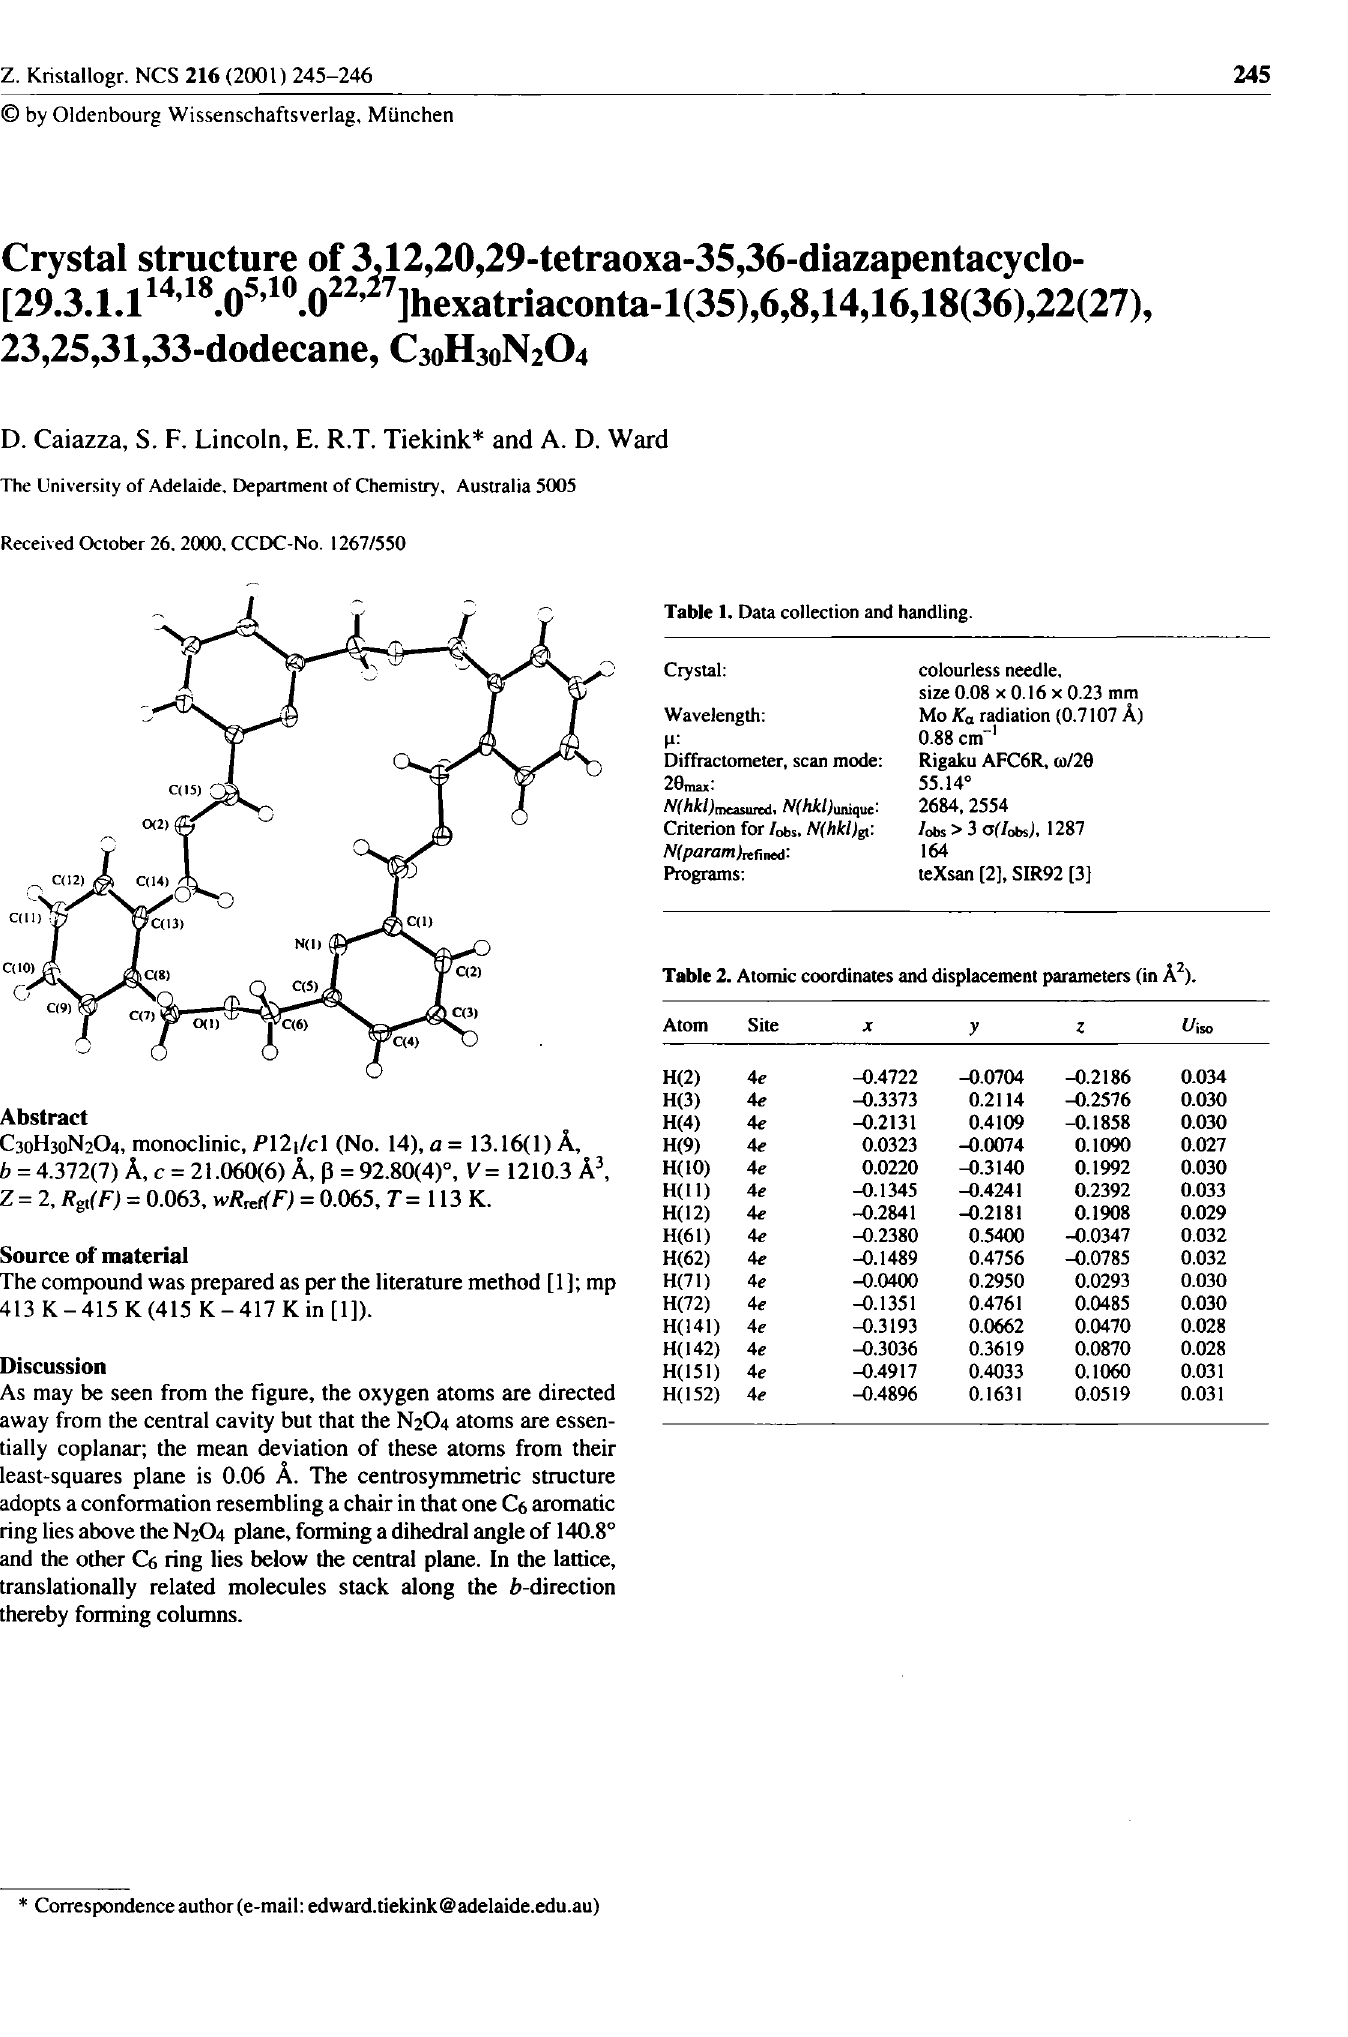
Table 1. Data collection and handling.